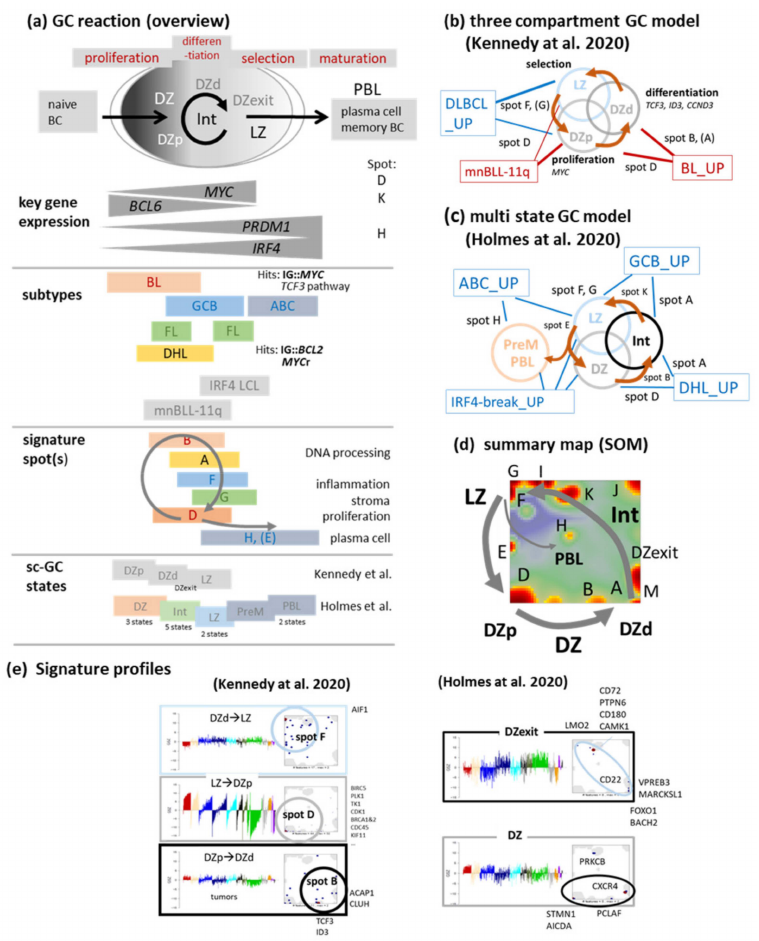
Figure 2. Beyond the GC-bipartition as seen by single-cell transcriptomics: ( a ) Schematic view of the GC reaction and its relation to spot expression. Naïve (pre-GC) B-cells maturate upon passing the germinal center (GC) into maturated B-cells and plasma cells. The GC divides into the dark (DZ) and light (LZ) zones, which associate with different functions and microenvironments, with typical expression changes of marker genes, spot-modules and lymphoma subtypes (adapted from [41,50], see also [42]). ( b ) Kennedy et al. [25] identified two separated cell states in the DZ fulfilling prolif- erative (DZp) and differentiating (DZd) functions, which tripartite the GC into DZp, DZd and LZ compartments. Gene signatures of them associate with spots D and B (and A), respectively (see part ( e )). BL and MYC -activated DLBCL share activated spot D while FL, DHL and BL share activation of spot A. Spot B is uniquely activated in BL (see profiles in Figure 1e). ( c ) The multistate model divides the GC reaction into DZ-, INT- (intermediate), LZ- and PBL-states (see Figure 3 and [24]). ( d ) The GC reaction appears as closed circle in the overexpression summary map visualizing the expression state space of lymphomas. It links spots G/F, D, B, A and K while plasma cell maturation forms a side branch towards spot H. ( e ) Signatures of GC states taken from both publications accumulate in distinct areas of our transcriptome SOM associating the respective spots with the GC reaction (Figures A5 and A6 for more details). DZexit was identified as expression state preparing the cells to exit DZ towards LZ via INT [24]. Tumors are ranked with increased cell cycle activity for each subtype. Spot D reflects strong association with cell cycle activity (ramp-like silhouettes) while spot B shows not (see Figure